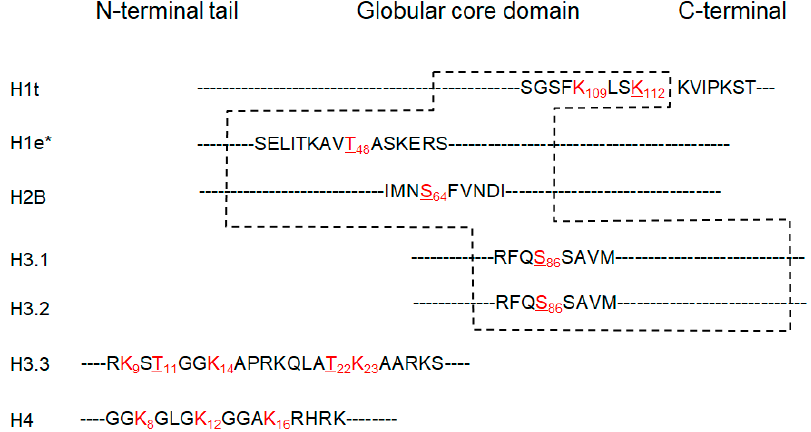
Figure 3. Human histone acetylation sites identified by the wide tolerance acetylation workflow. A diagram showing sites of histone acetylation identified by the wide tolerance acetylation workflow. Red, acetylation sites; underlined, new in human histones; dotted box, the globular core domain; subscript, position of the amino acid residues; *, liver histone H1e.